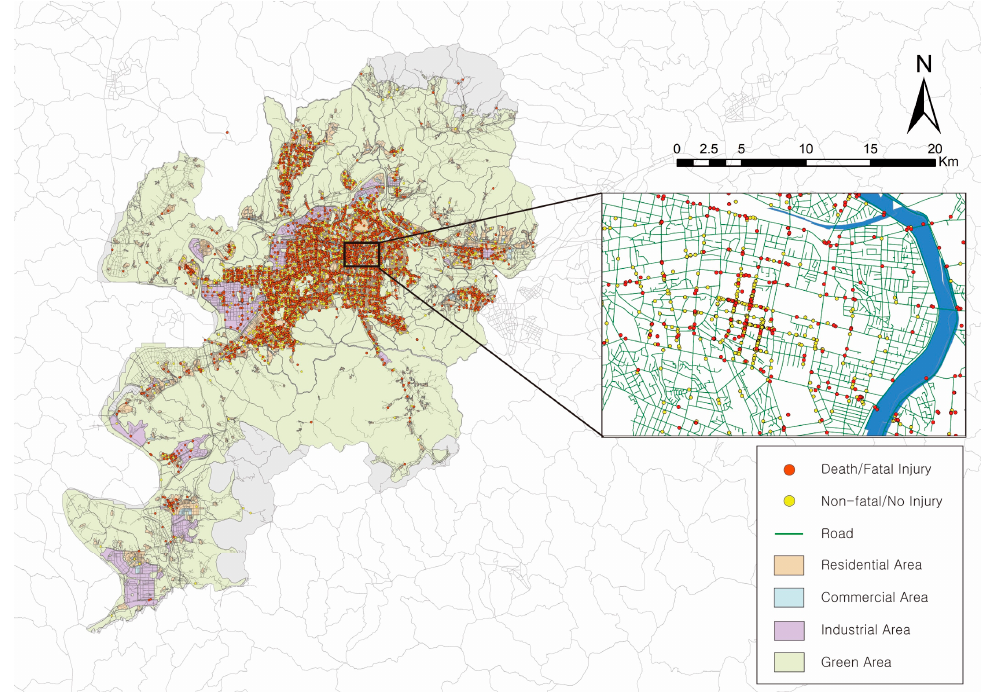
Figure 1. Daegu Metropolitan City and the spatial distribution of pedestrian-vehicle crashes.